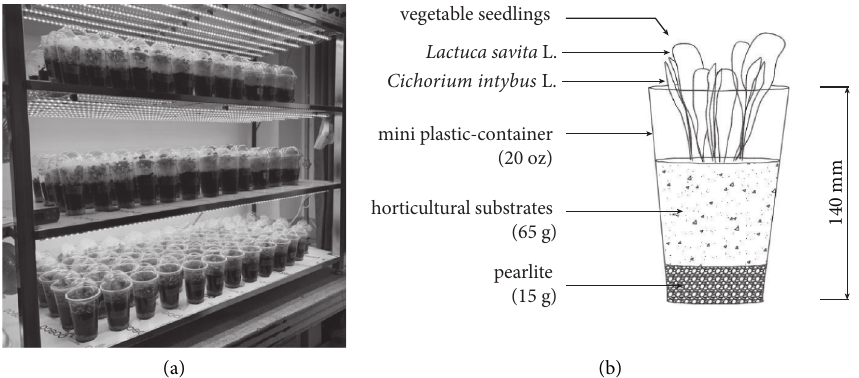
Figure 3: The indoor LED plant growth chamber experiments (a) and the cross section of miniplastic container (b) with different ratios of seed mixtures between lettuce and